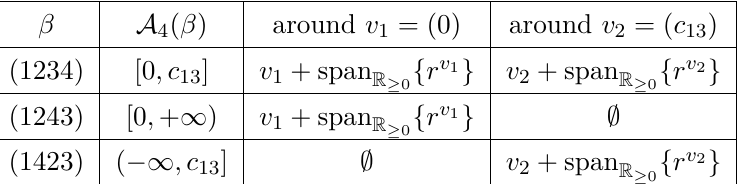
Table 4 . Associahedra for n = 4 in the neighbourhood of each vertex in V 4 as one-dimen- sional cones.